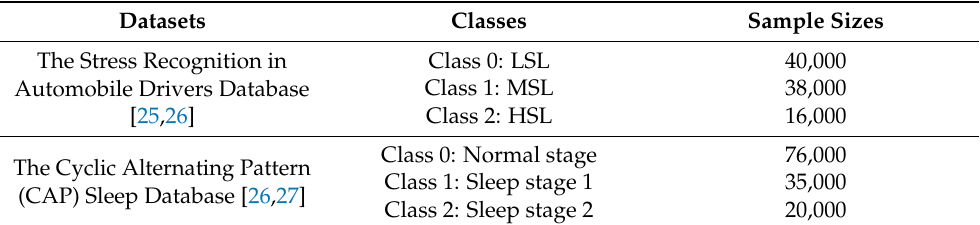
Table 1. Summary of the classes and sample sizes of the real-world driving datasets after ECG beat